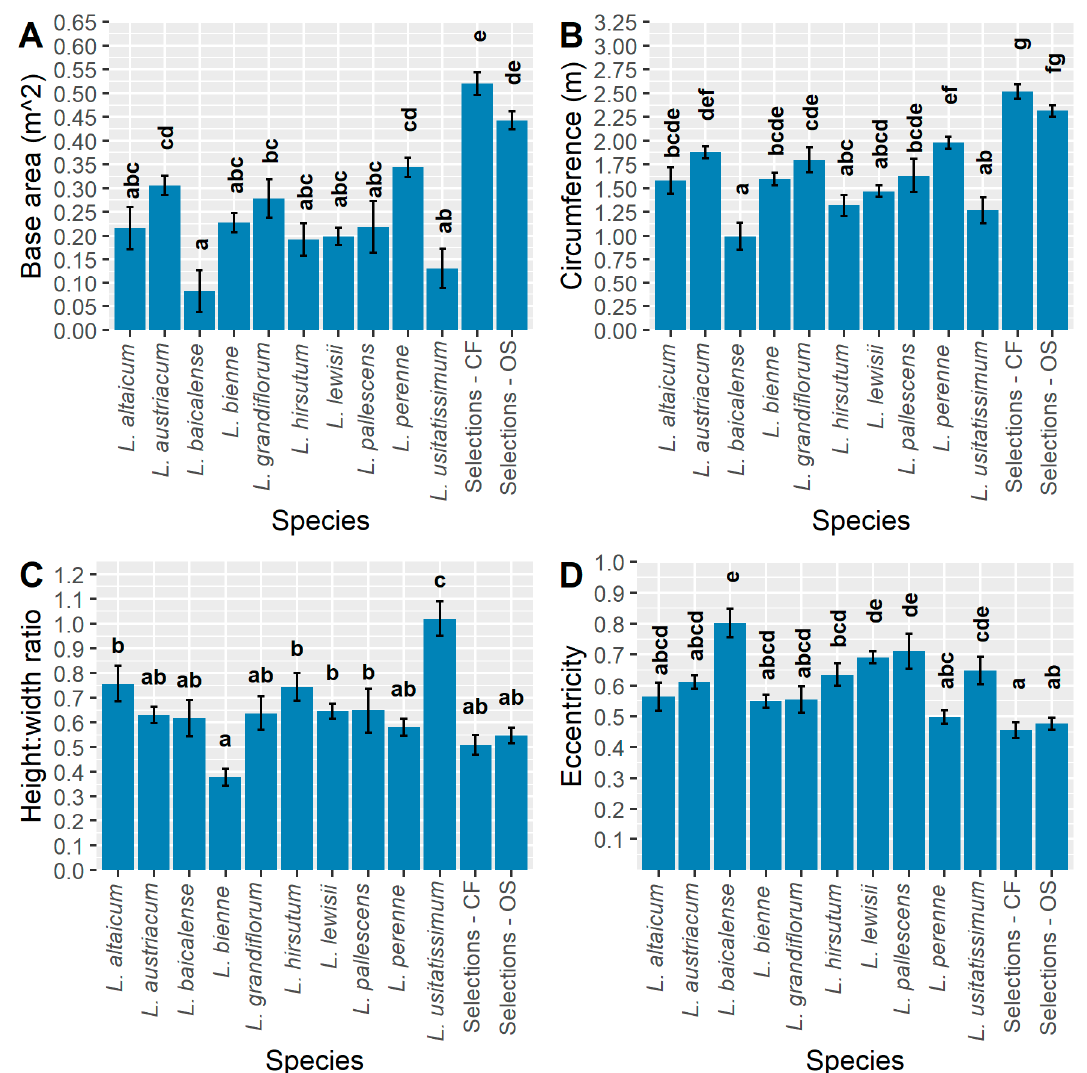
Figure 8. Comparison of wild flax species with CF and OS selections for mean ± S.E. year one plant size and shape trait values: ( A ) base area (m 2 ), ( B ) circumference (m), ( C ) height:width ratio, and ( D ) eccentricity (e). Mean separations are displayed as letters above the columns denoting significance.